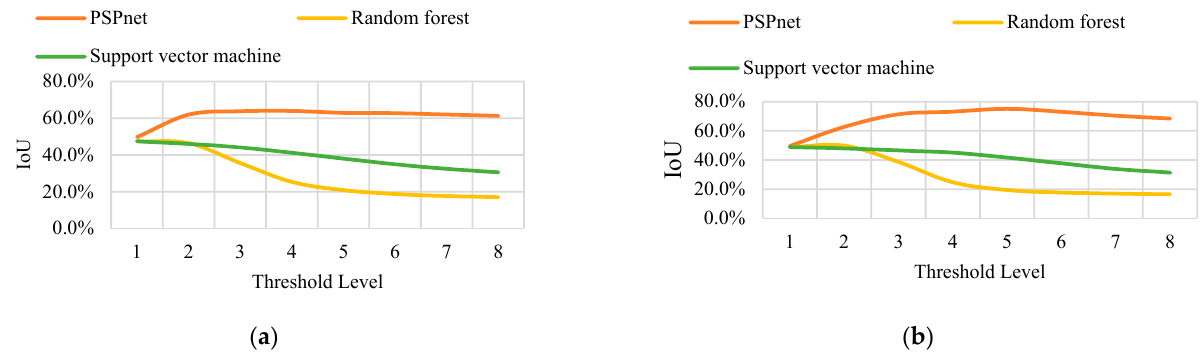
Figure 9. ( a ) The IOU curve of S = 35 obtained by the three classification methods changes with the threshold. ( b ) The IOU curve of S = 70 obtained by the three classification methods changes with the threshold.